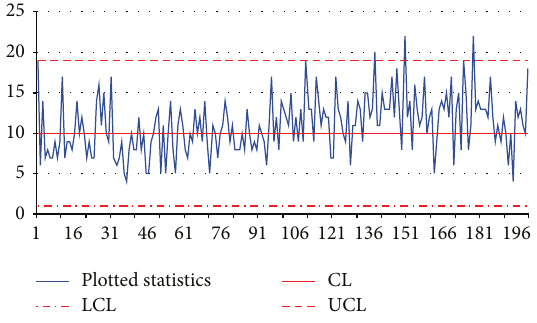
Figure 1: An 𝑛𝑝 control chart for monitoring a binomial process.